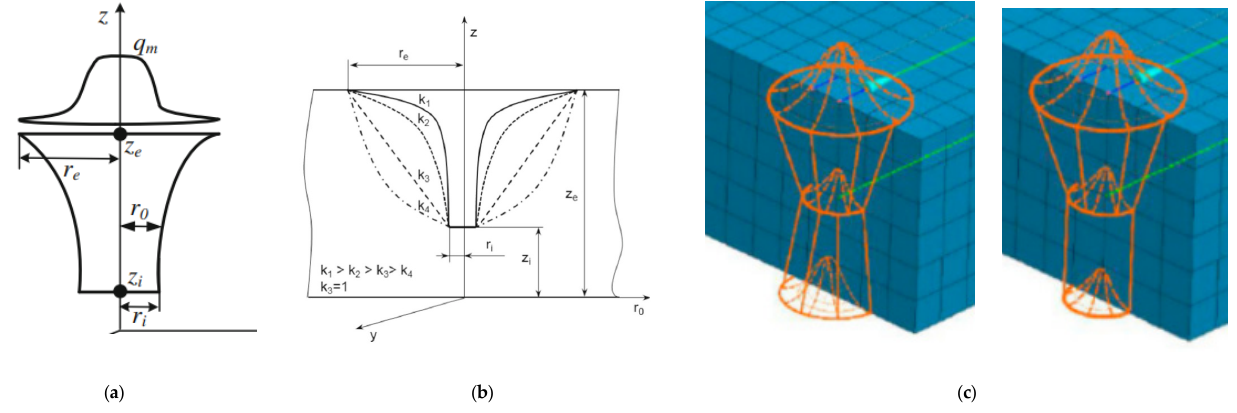
Figure 1. Laser heat source models. ( a ) Curve model; ( b ) exponential model; ( c ) conical-conical and conical-cylindrical models.